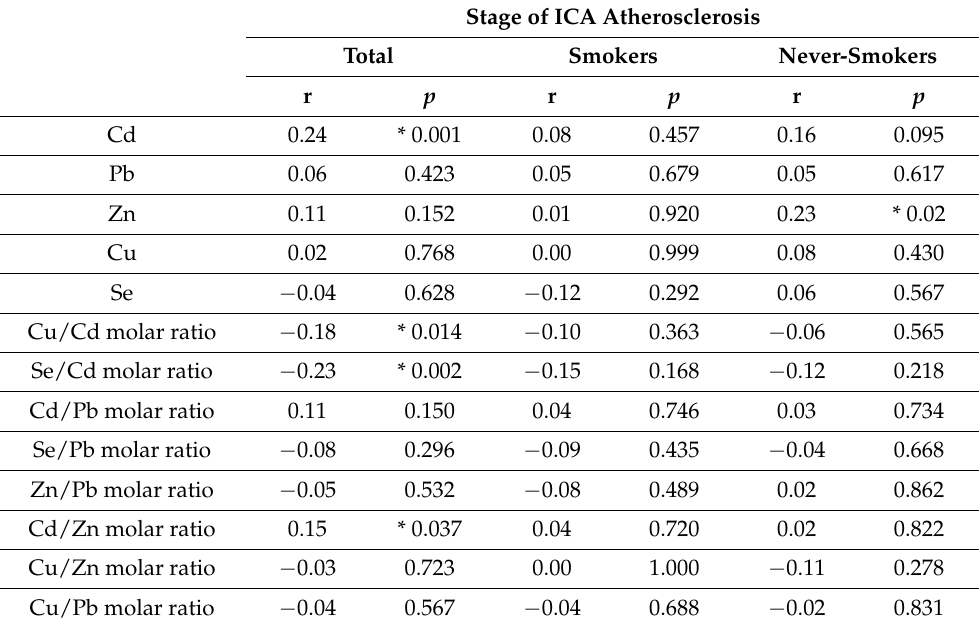
Correlations were found between the internal-carotid-artery atherosclerosis stage and B-mode external-carotid ultrasound imaging using a standardized protocol or neck CT angiography, TEs and molar ratio of these TEs concentrations in acute ischemic stroke patients. Nevertheless, following the adjustment for smoking status, these correlations were exhibited to be not statistically significant ( p > 0.05). Abbreviations: Internal carotid artery, ICA.